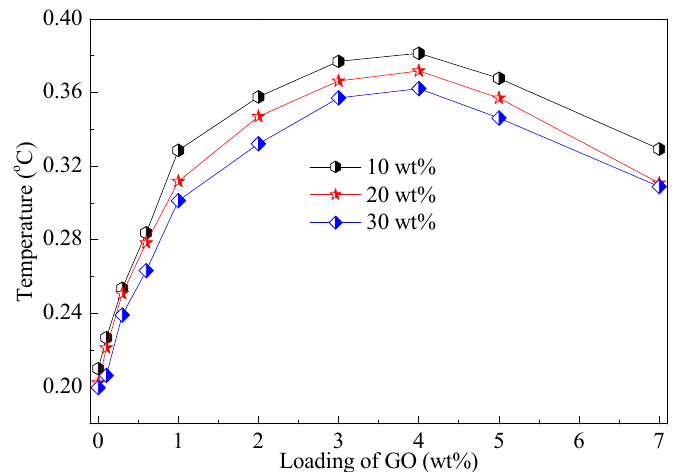
Figure 6. Thermal conductivity of GO-TPU film with difference loadings of GO and the initial concentration of TPU of 10 wt %, 20 wt %, and 30 wt %, respectively.